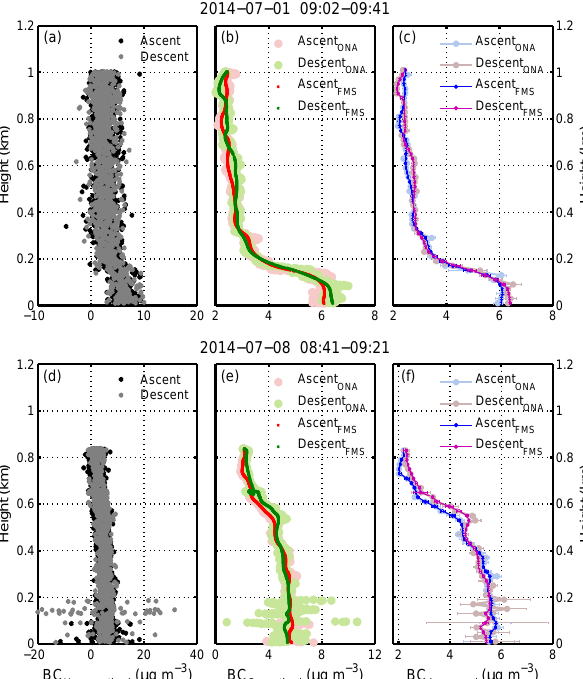
Figure 3. (a) Unsmoothed BC mass concentrations measured with a temporal resolution of 1s on 1 July 2014 (09:02–09:41LT). Data points collected from the ascending and descending process are re- spectively marked in black and gray dots. (b) Smoothed BC mass concentrations using two algorithms. Data points processed by the ONA method are displayed in large pink dots for the ascent and in light green for the descent. Data points processed by the FMS method are denoted by small red dots for the ascent and green dots for the descent. (c) 20m averaged profiles based upon smoothed data using two algorithms. Dots indicate 20m averages, with stan- dard deviations in error bars. Results from the ONA and FMS meth- ods are respectively given in light blue and blue for the ascent, while in light purple and purple for the descent. (d–f) Measured and pro- cessed BC vertical profiles on 8 July 2014 (08:41–09:21LT). The caption is the same as that in (a) – (c)